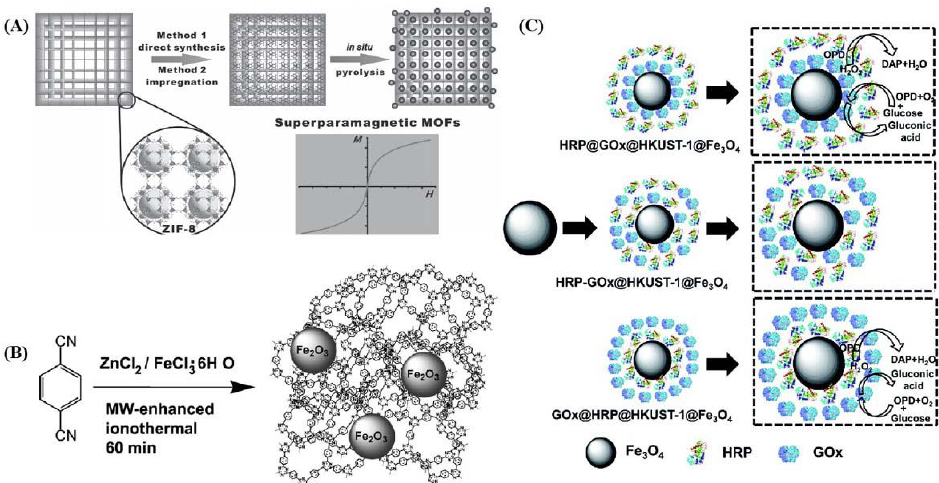
Figure 6. Schematic illustration of MMOF synthesized procedures and related applications. ( A ) Preparation of superparamagnetic metal–organic frameworks of γ-Fe 2 O 3 @ZIF-8; ( B ) CTF/Fe 2 O 3 composite synthesized by the microwave-enhanced high-temperature ionothermal method, (CTF = covalent triazine-based framework); ( C ) Three different strategies for the positional assembly and spatial co-localization of glucose oxidase and horseradish peroxidase. These are reprinted with permission from Wu et al. (2014, Wiley), Zhang et al. (2011, Elsevier), and Chen et al. (2017, RSC), respectively.